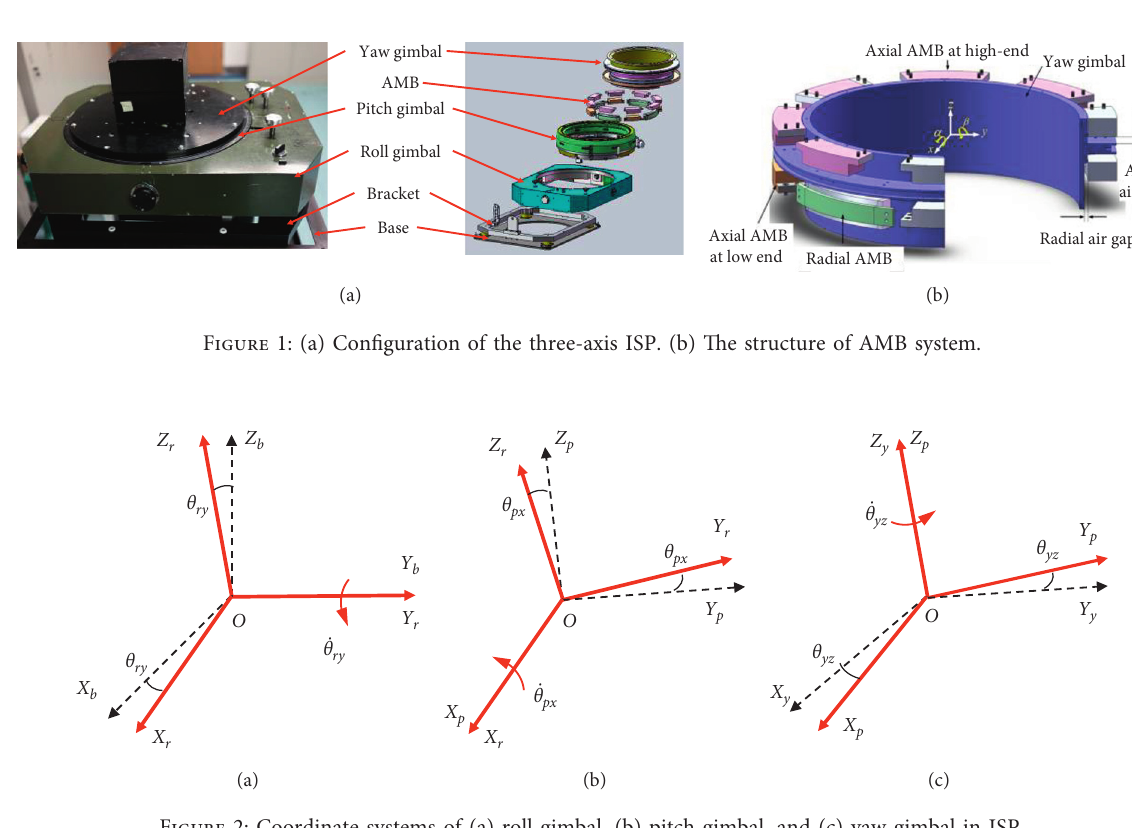
Figure 2: Coordinate systems of (a) roll gimbal, (b) pitch gimbal, and (c) yaw gimbal in